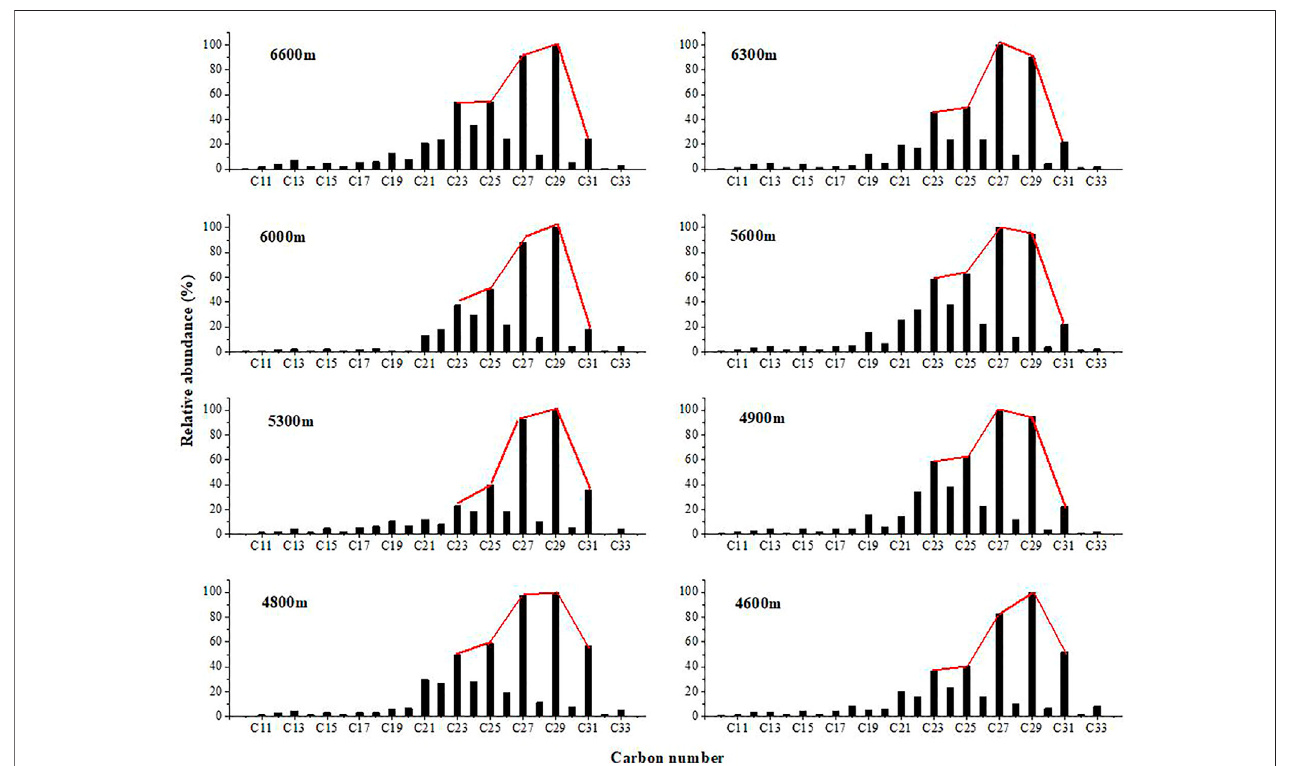
FIGURE 2 | Distributions of n -alkane in the sediment samples from Gongga